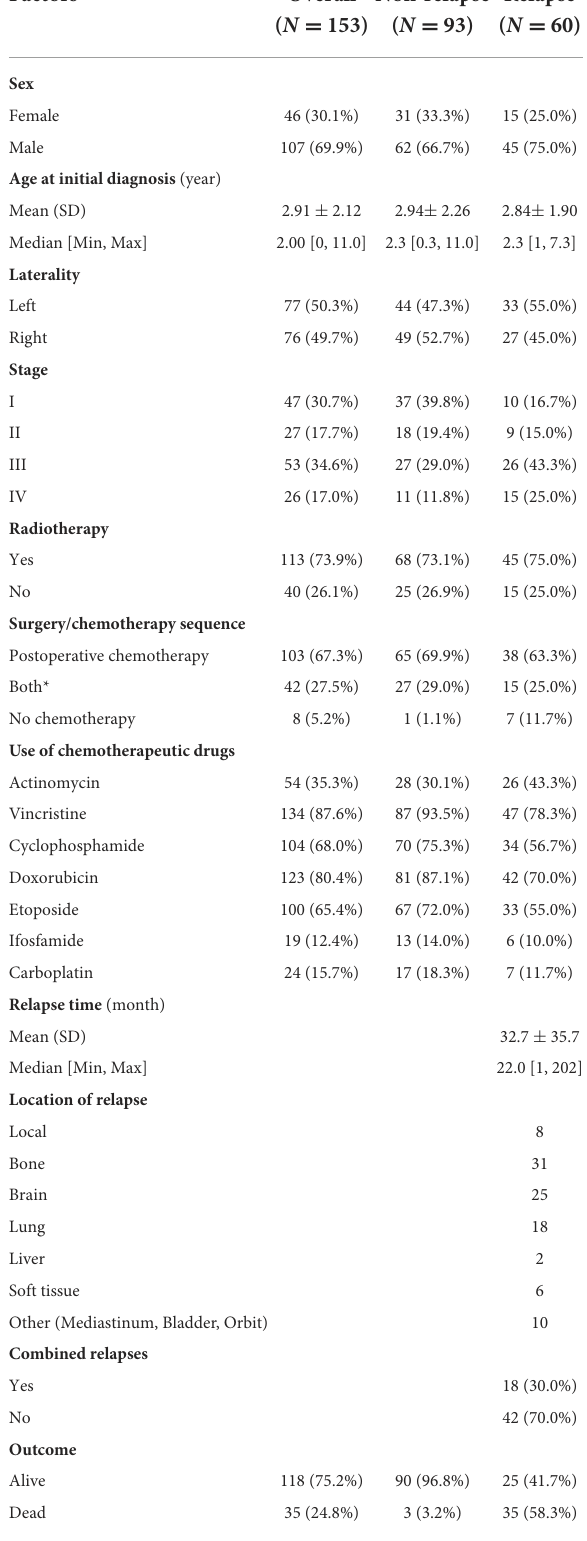
TABLE 4 Clinical characteristics in the relapse